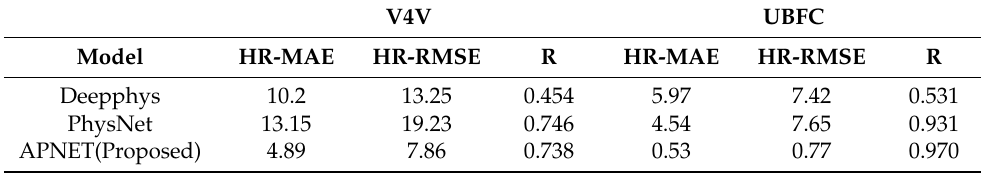
Table 7. Comparison of quantitative assessment results with representative